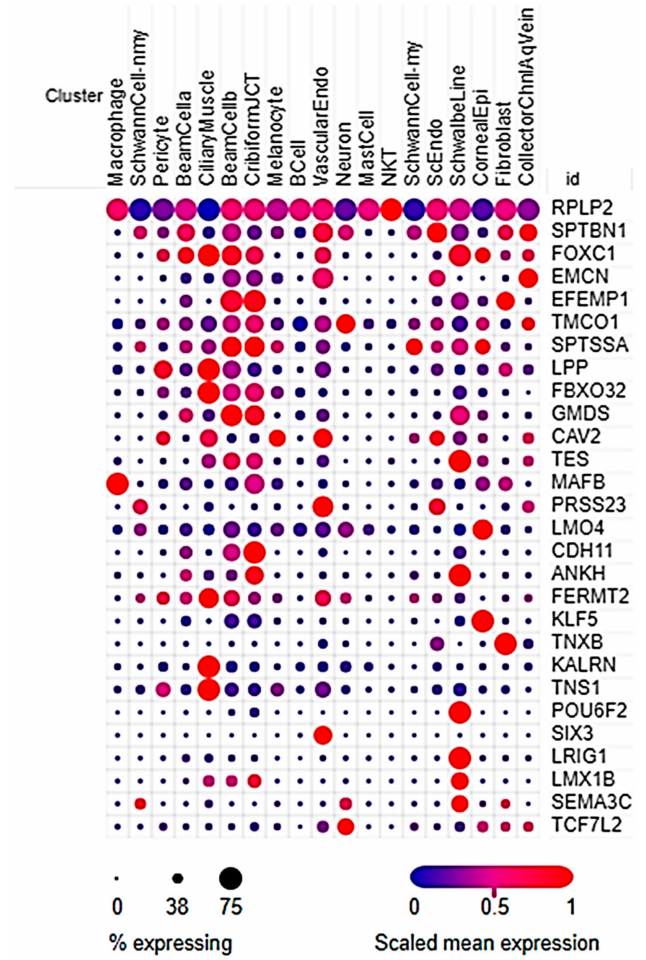
Figure 3. Genes expressed in single-cell RNA-sequencing (scRNA-Seq) cell clusters. Twenty-nine intraocular pressure-associated genes were specifically expressed in one or more of the 19 cell clusters defined by scRNA-Seq of human aqueous humor outflow tissue. Genes expressed in a high percentage of cells within a cluster are represented by a large dot while genes expressed in a low percentage of cells are represented by a small dot. Highly expressed genes appear more red while lowly expressed genes appear more blue. Cell clusters included Macrophage, Non- Myelinated Schwann Cell (SchwannCell-nmy), Pericyte, Trabecular Meshwork Beam Cell A, Ciliary Muscle, Trabecular Meshwork Beam Cell B, Cribiform Juxtacanalicular Trabecular Meshwork Cell (CribiformJCT), Melanocyte, B Cell, Vascular Endothelium (VascularEndo), Neuron, Mast Cell, NKT Cell, Myelinated Schwann Cell (SchwannCell-my), Schlemm’s Canal Endothelium (ScEndo), Schwalbe Line Cell, Corneal Epithelium (CornealEpi), Fibroblast, and Collector Channel/Aqueous Vein Endothelium